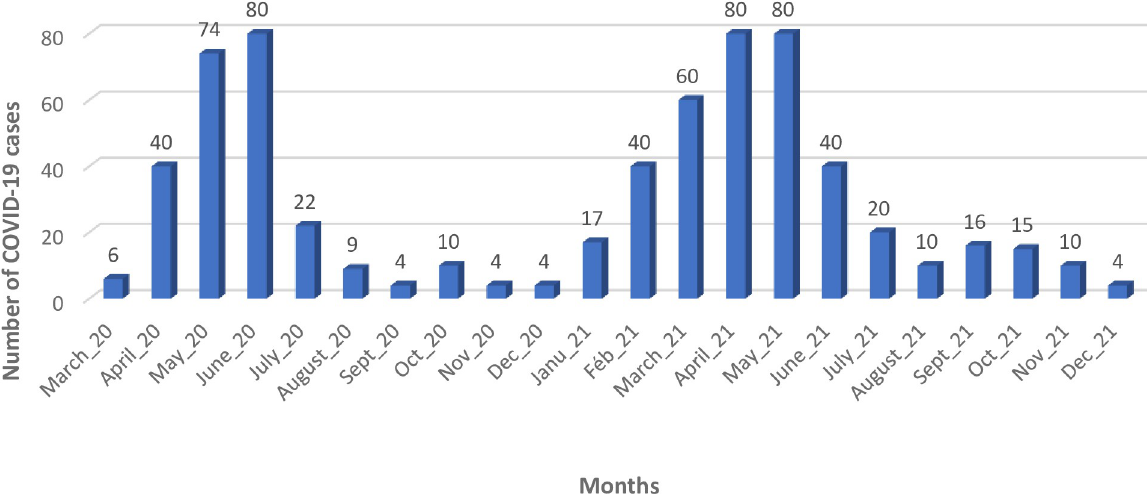
Fig 2. Temporal distribution of COVID-19 confirmed cases: Hospitalised cases and deaths. March 2020-December 2021.